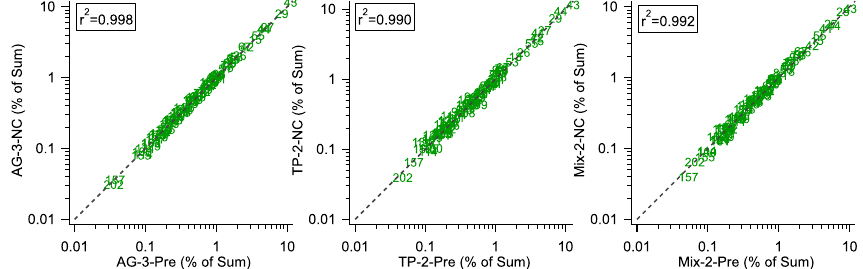
Figure 1. Scatter plots comparing the normalized spectra of all three paired pre-treatment/negative-control experiments. The markers denote the m/z . Only the 89 UMR m/z signals used in the correlation analyses are plotted. The x axis is the percent contribution to total organic mass for the pre-treatment experiment and the y axis is the percent contribution to total organic mass for the paired negative control experiments. The dashed gray 1:1 lines are shown for reference. AG-3 is an Abies grandis experiment. TP-2 is a Thuja plicata experiment, Mix-2 is a mixed Abies grandis and Pseudotsuga menziesii experiment. Correlations ( r 2 ) between the negative control spectra and the pre-treatment spectra are shown in the boxes on each